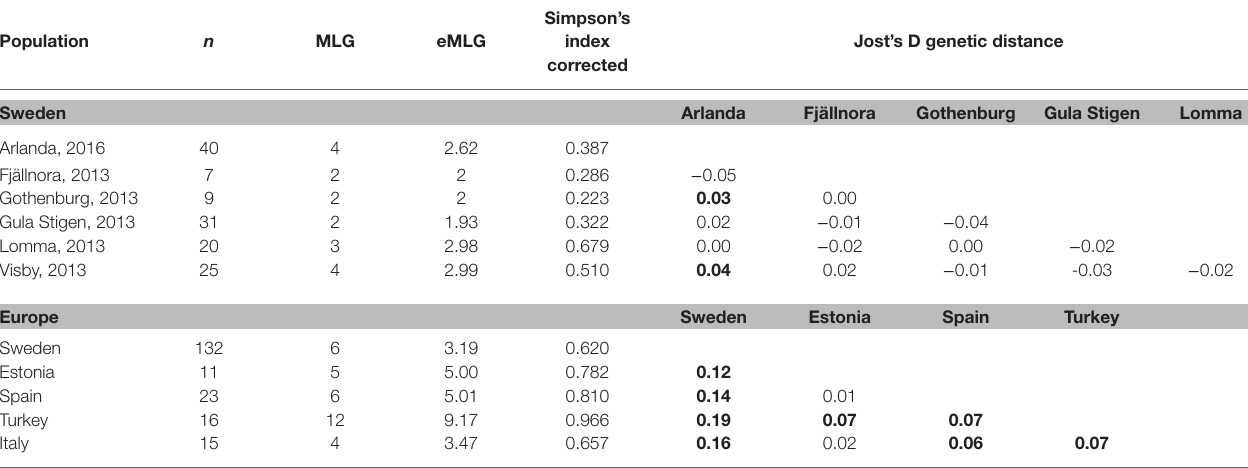
TABLE 1 | Population structure among Diplodia sapinea isolates from five different locations in Sweden collected in 2013 and from the location of the outbreak, and genetic distance among Sweden’s D. sapinea population and other four populations in Europe. Population n MLG eMLG